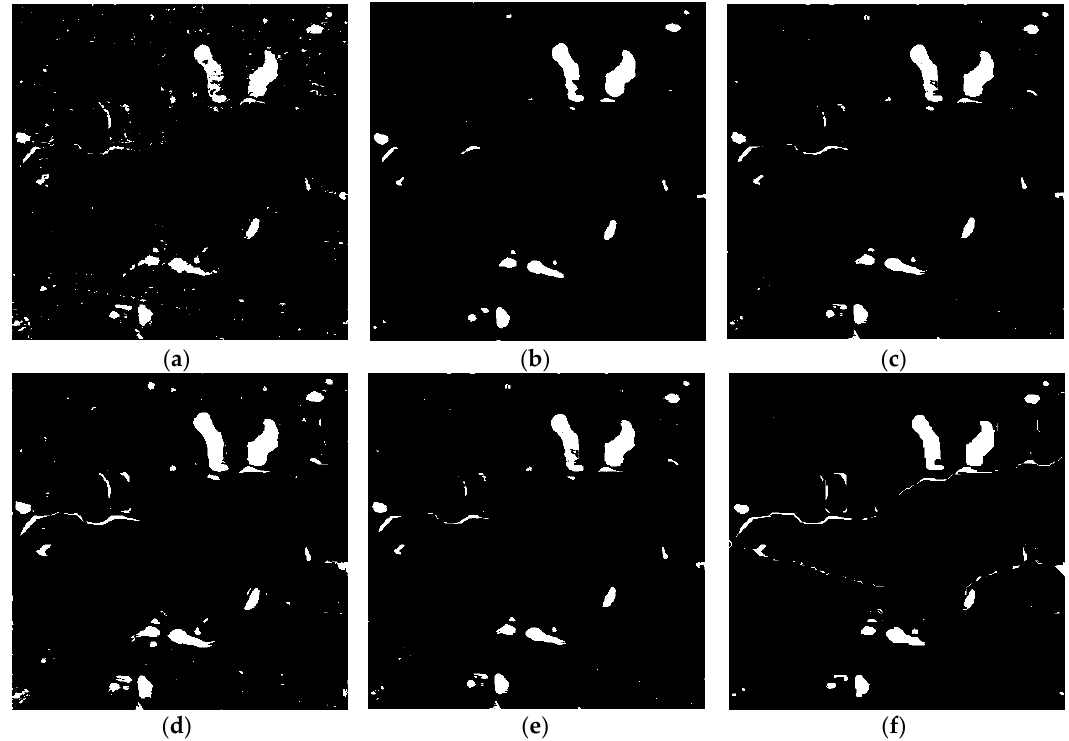
Figure 7. Change detection results of the different algorithms over LiangZi Lake between 2011 and 2015. ( a ) Change detection result using OT_GGMM_pix ( k = 16). ( b ) Change detection result using OT_GGMM_obj ( k = 14). ( c ) Change detection results using OT_GSRM_TDES. ( d ) Change detection